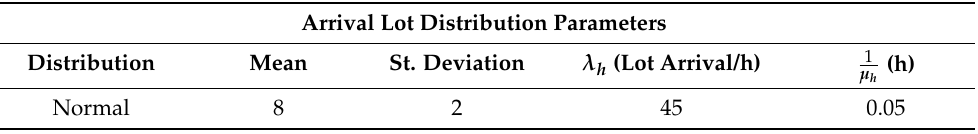
Table 4. Lot size distribution, arrival rate and service rate of M x /M/ ∞